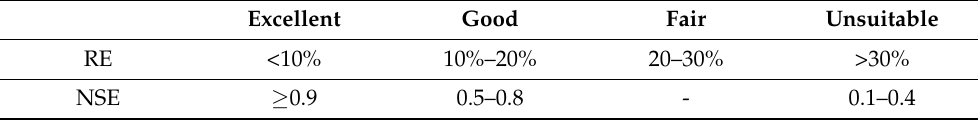
Table 2. Classification of predictive ability of models evaluated by the RE and